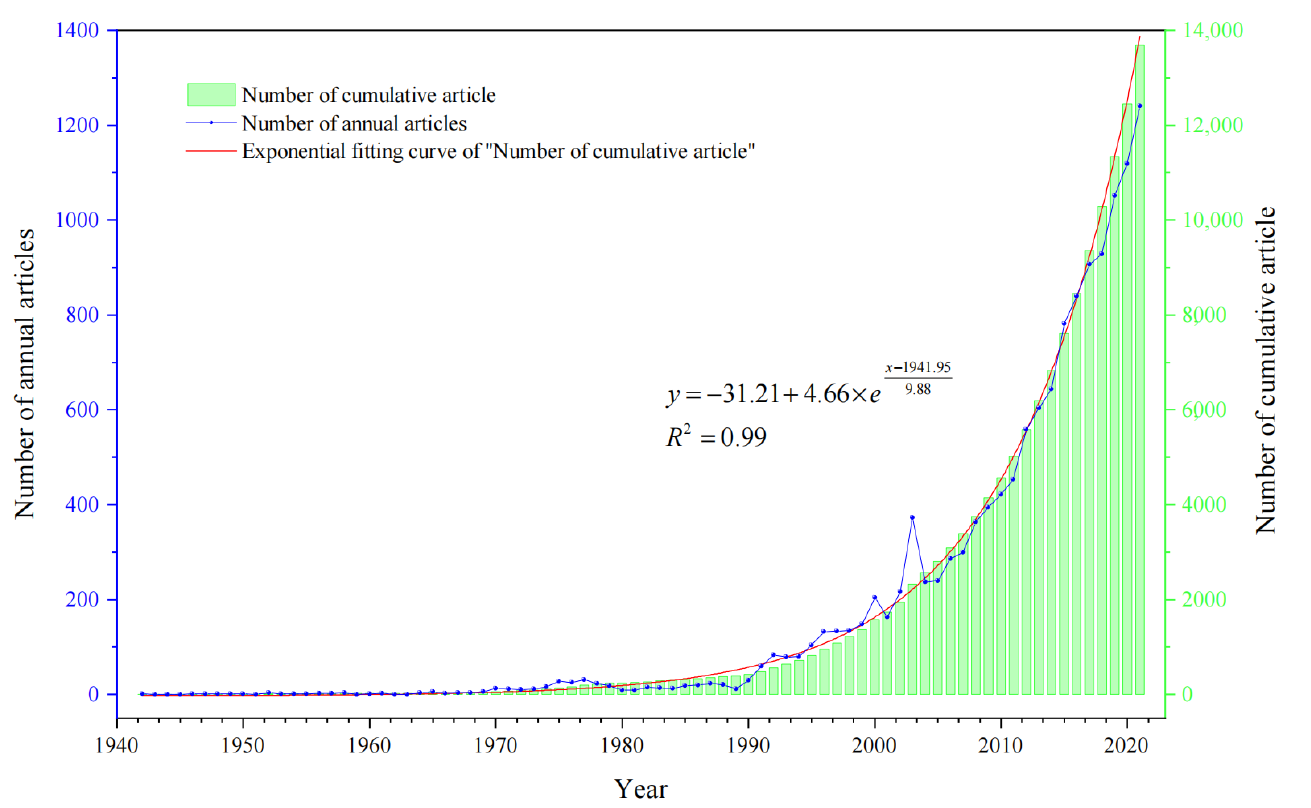
6 of 35 Figure 1. Schematic diagram and main steps of bibliometric analysis method, adapted with per- mission from publications [39,40,81,82]. Copyright 2017, Aria and Cuccurullo; copyright 2019, Firdaus et al.; copyright 2020, Secinaro et al.; and copyright 2022, Xu et al. 3. Results 3.1. Overall Bibliometric Descriptive Analysis